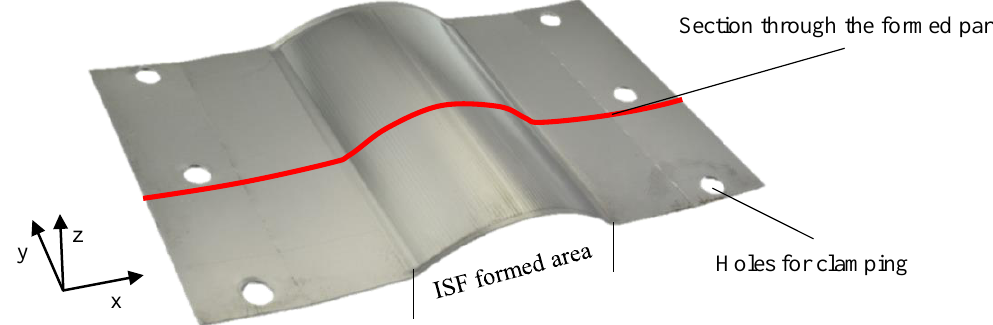
Figure 11. Specimen formed by stretch forming and ISF with an intrusion depth of 0.3 mm with analyzed section (red line).